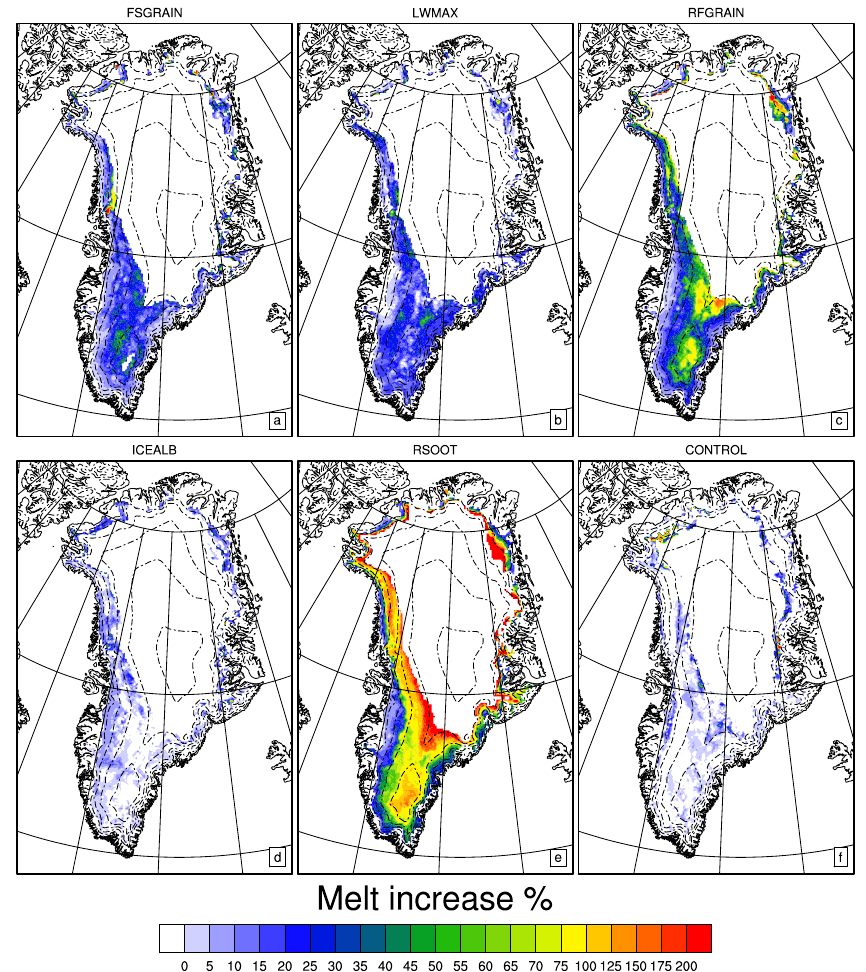
Fig. 9. The relative increase in snowmelt energy compared to the preceding simulation in Table 1. Panel FSGRAIN (a) shows the increase in snowmelt compared to the ANT simulation. As threshold a minimum of 10mmw.e. snowmelt is